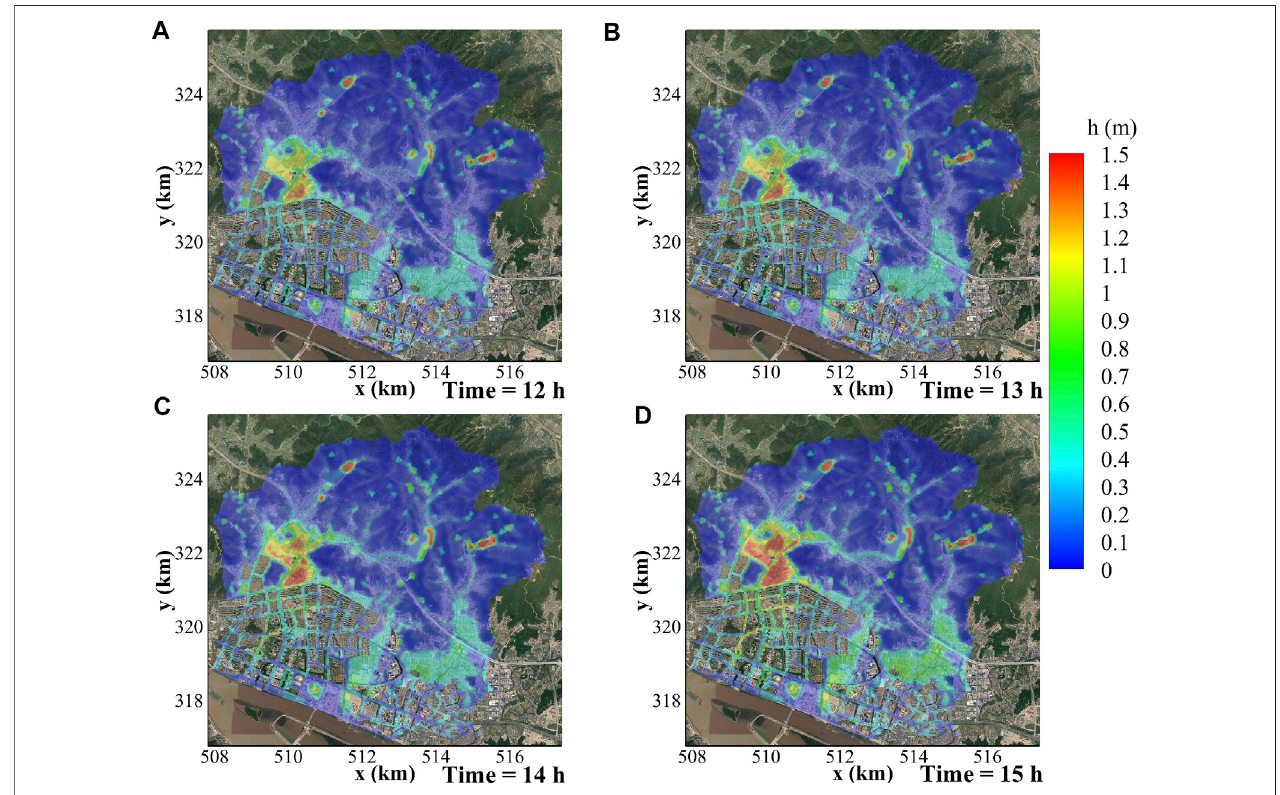
FIGURE 4 | Temporal and spatial evolution of water depth for PSWM in Case 1 at (A) 12 h, (B) 13 h, (C) 14 h and (D) 15 h.